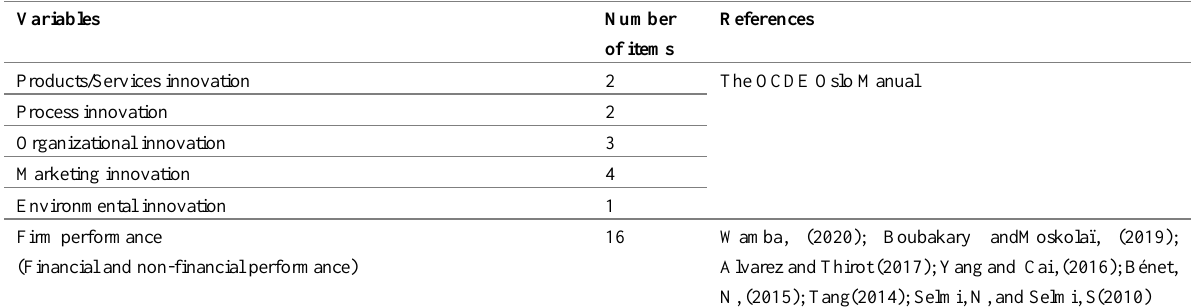
Table 2: List of variables and number of research items